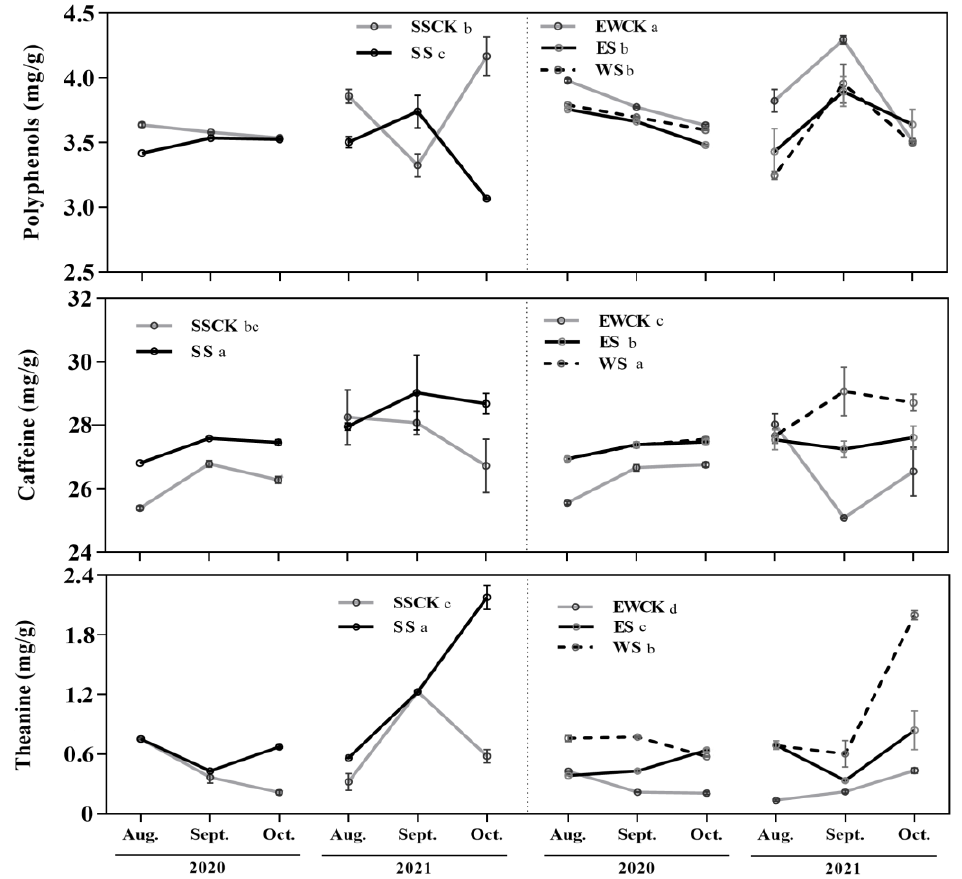
Figure 3. Foliar contents of bioactive components of tea plants under the roadside tree ecological shading. (Note: different lowercase letters indicate significant differences among the ecological-shade treatments, and the control no-shading treatments, using the LSD test at p <